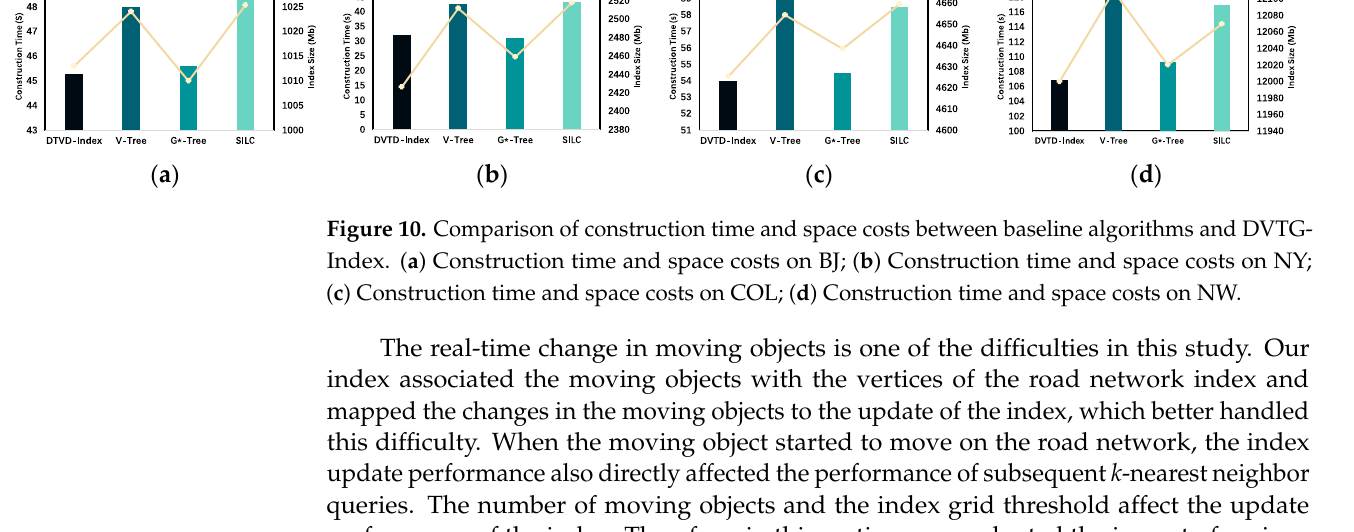
( b ) Figure 11. Time cost of updating DVTG-Index w.r.t. the number of moving objects. ( a ) Time cost on BJ; ( b ) Time cost on NY, COL and NW. Then, we evaluated the impact of index grid threshold 𝜂 on the index update time. Among them, in the BJ dataset, the taxi trajectory between 8:00–9:00 on February 2 was obtained, and in datasets NY, COL, and NW, 5% of the number of vertices was used as the number of moving objects. As shown in Figure 12, it can be seen from the experimental results that there is no positive or negative correlation between the index update time cost and index grid thresh- old 𝜂 . When the threshold is relatively small, as the moving objects change, the index grid is more likely to be split down or merged up until the number of moving objects in the 05101520 25 30354045